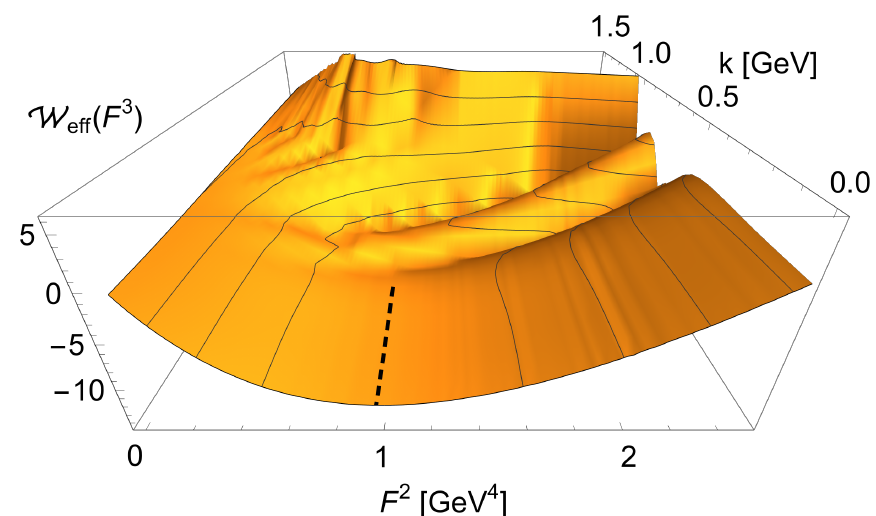
Figure 3: Effective Potential as a function of F 2 with a field strength pointing in the t 3 -direction, ( n 3 , n 8 ) = ( 1,0 ) , and the cutoff scale k . The dashed line singles out the absolute minimum of W ( F ) , see eq. (68). The substructure of the potential at cutoff scale k (cid:166) 0.5 GeV is related to the regulator used, see Appendix D. It leaves no trace in the potential for k →